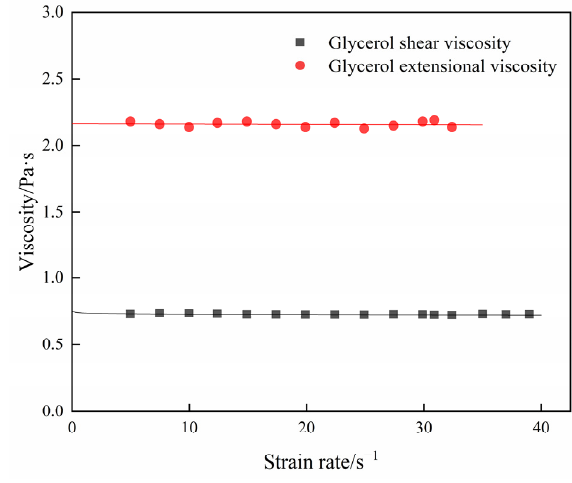
Figure 3. Rheological properties of glycerol.